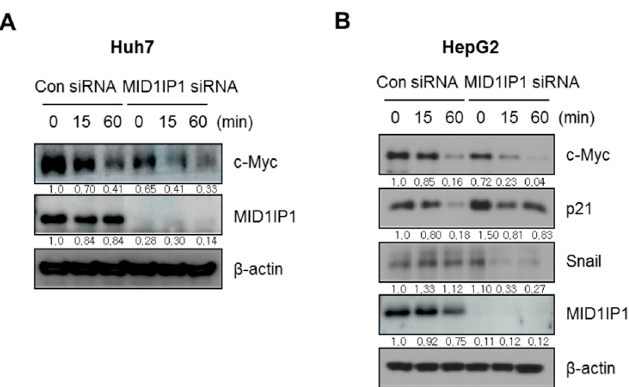
Figure 4. MID1IP1 depletion attenuates c-Myc stability in HepG2 and Huh7 cells in the presence of